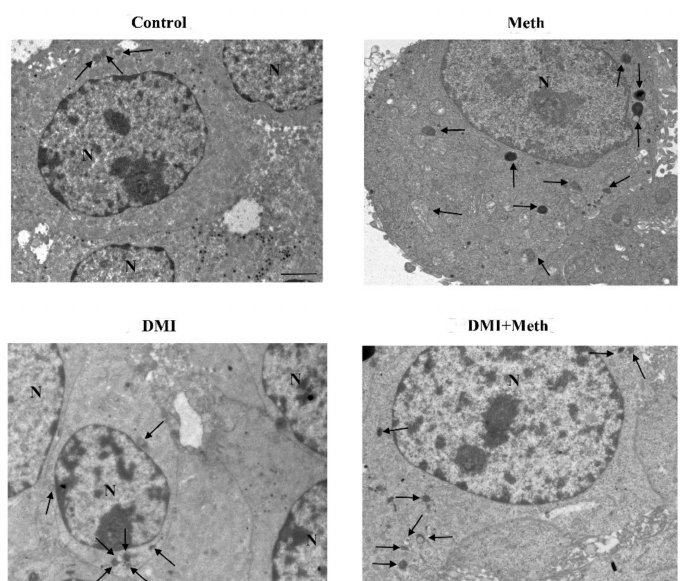
Figure 19. Representative TEM micrograph of autophagy-like vacuoles following DMI and Meth (low magnification). Representative micrographs of Control, Meth (50 µ M), the selective NET blocker DMI (100 nM), or DMI (100 nM) + Meth (50 µ M)-treated cells. Cells were fixed at 72 h after Meth administration. In the combined treatment, DMI was administered 45 min before Meth. Autophagy- like vacuoles are shown (arrow). Scale bar = 1 µ M. N = nucleus.